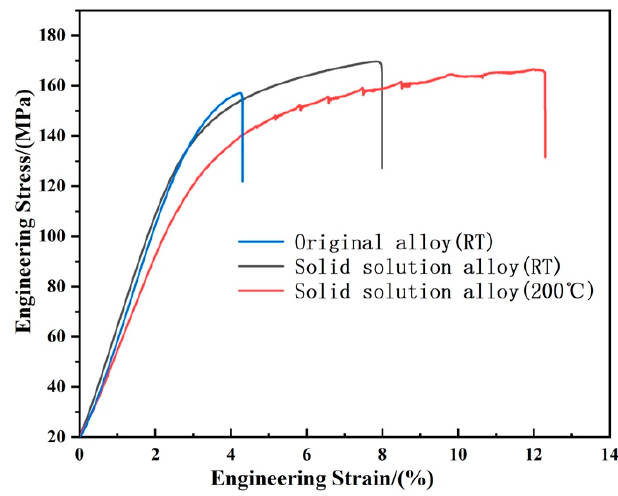
Figure 9. Engineering stress–strain curves of different alloys.